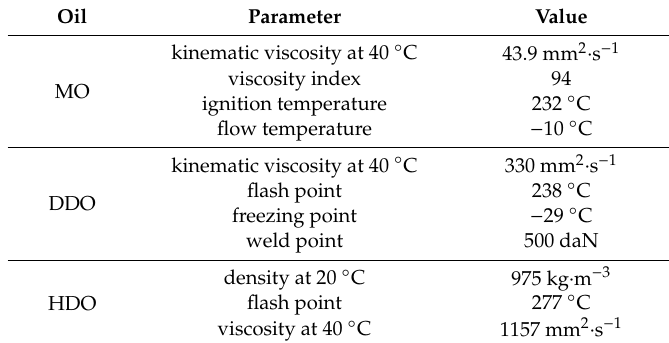
Table 6. Selected properties of synthetic oils